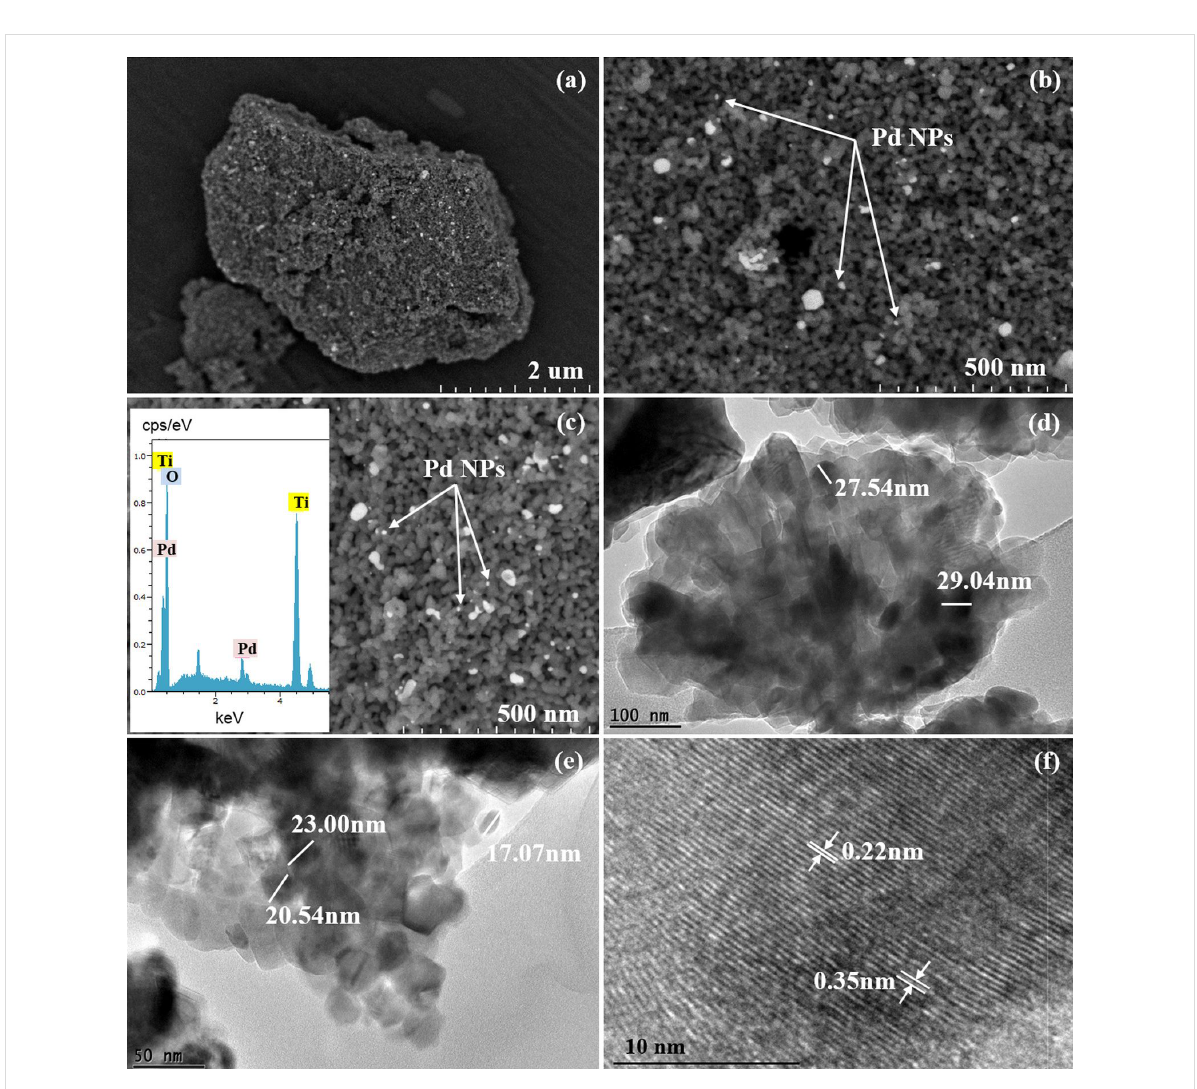
Figure 2: FESEM images of a) low magnification, b,c) high magnification of 0.5 wt % Pd/TiO 2 . The inset of c) is the EDX spectrum of 0.5 wt % Pd/TiO 2 and d–f) HRTEM images of 0.5 wt % Pd/TiO 2